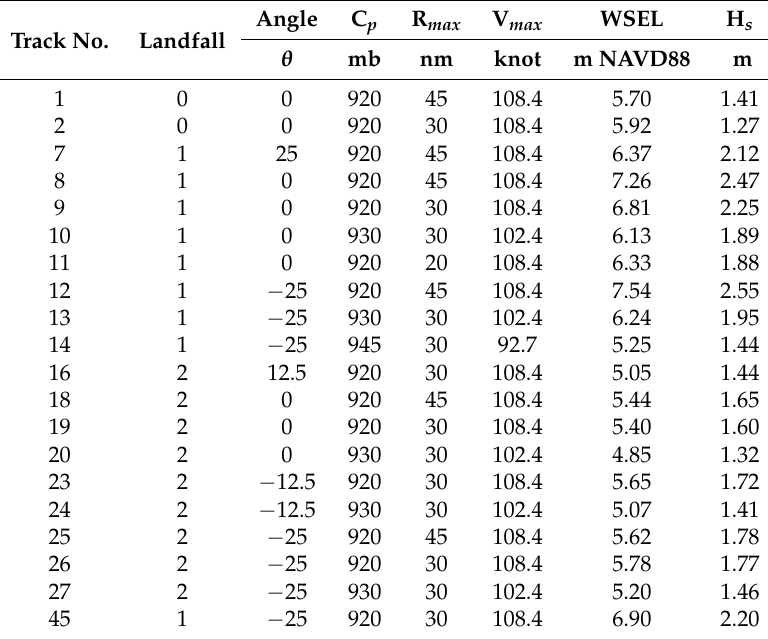
Table 5. Maximum Water Surface Elevation (WSEL) and wave height results for selected synthetic hurricane tracks. Landfall location is a multiplication of the R max , nm stands for nautical miles, and mb stands for milibar. Each knot is 1.15 mile per hour.